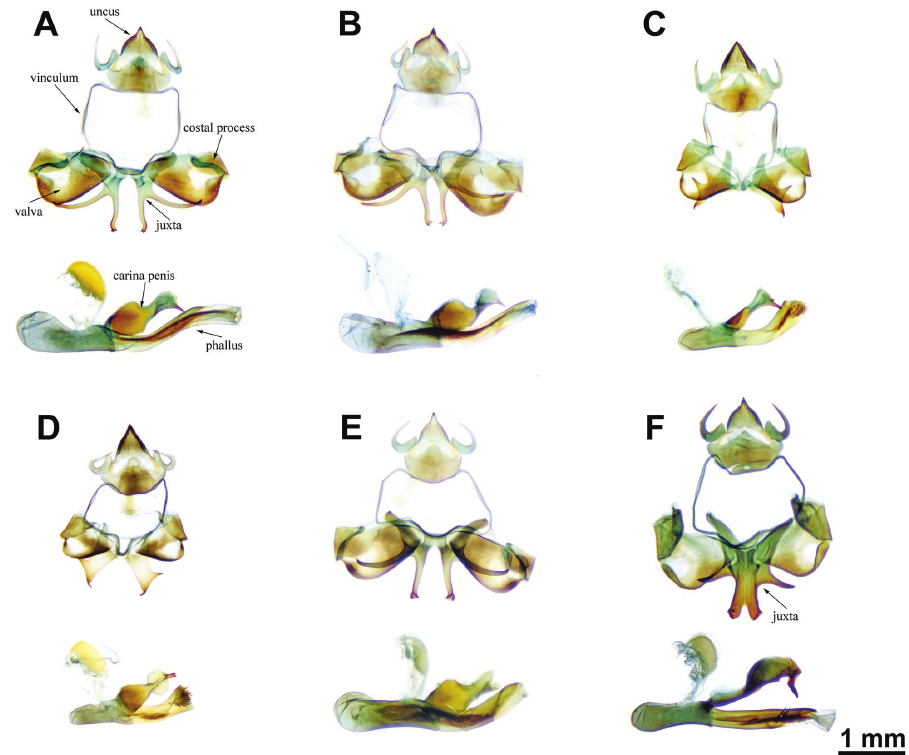
Figure 1. Male genitalia of Dodona samples. A D. formosana (spp. formosana ) B D. formosana (spp. esakii ) C D. eugenes eugenes D D. eugenes venox E D. egeon F D. maculosa